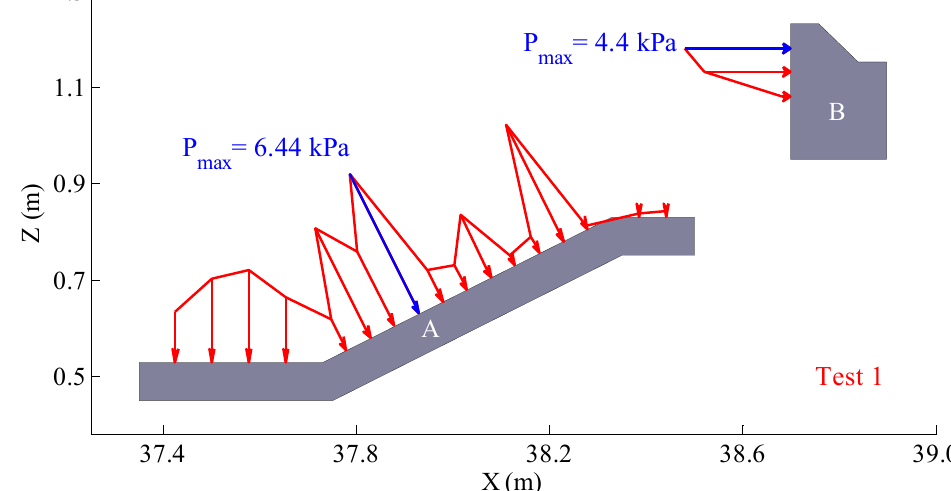
Figure 14. Distribution of the maximum wave impact on the surface of the revetment breakwater under regular wave loading in Test 1.